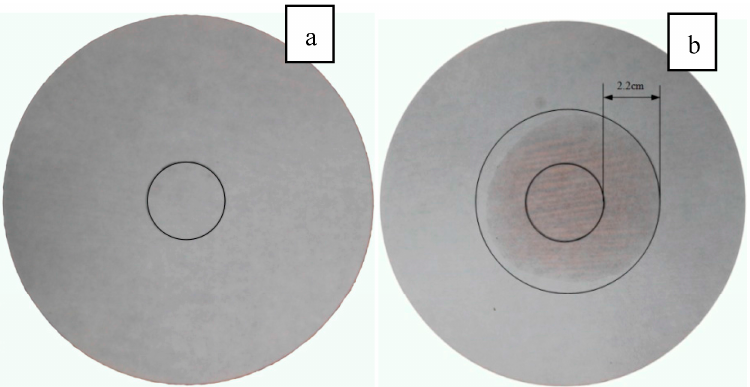
Figure 13. Leakage performance of TD-LA/EP-AP: ( a ) PCMP with surface film; and ( b ) PCMP without surface film.